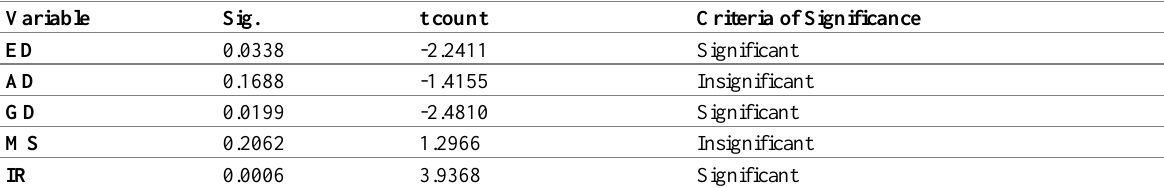
Table 7: Results of Partial